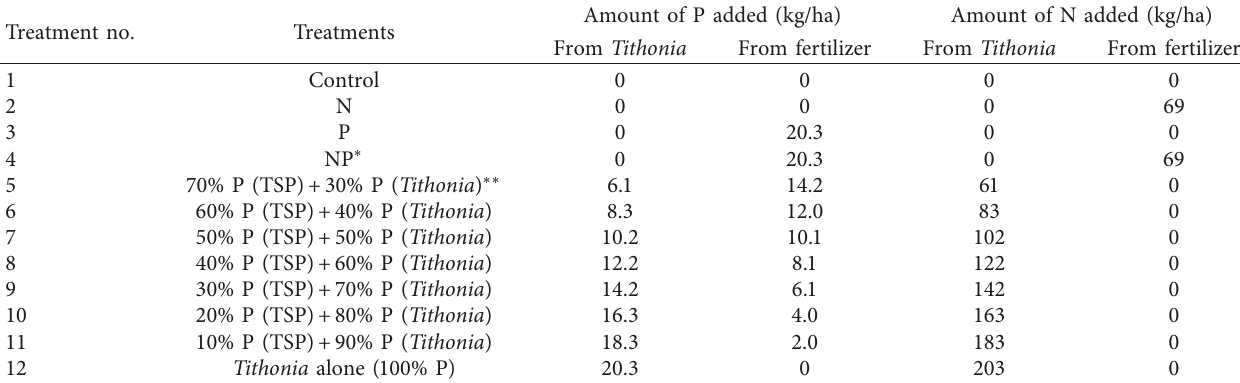
Table 2: Description of the